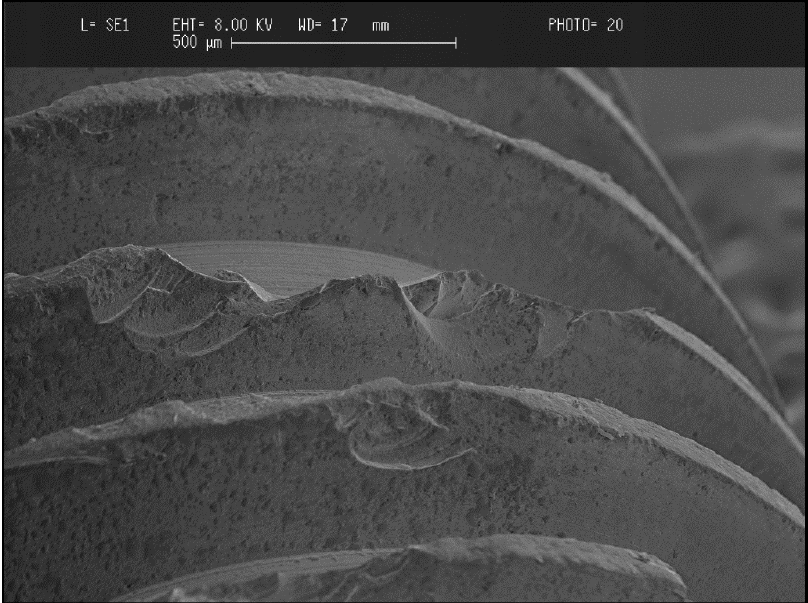
Figure 4. SEM image of failed retrieved zirconia implant showing the vulnerability of deep, thin, sharp thread edges easily fractured with a trephine